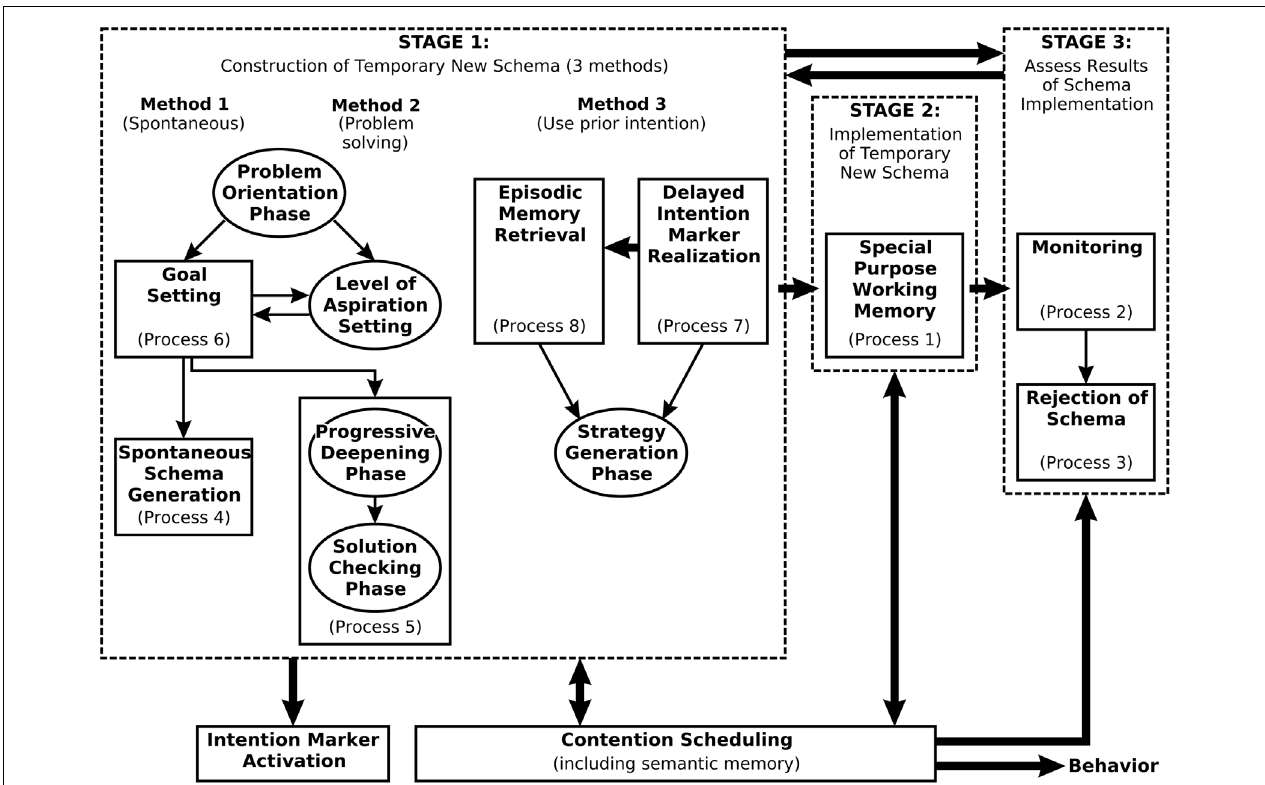
FIGURE 5 |The Contention Scheduling/Supervisory System model of Norman and Shallice (1986), as elaborated by Shallice and Burgess (1996).